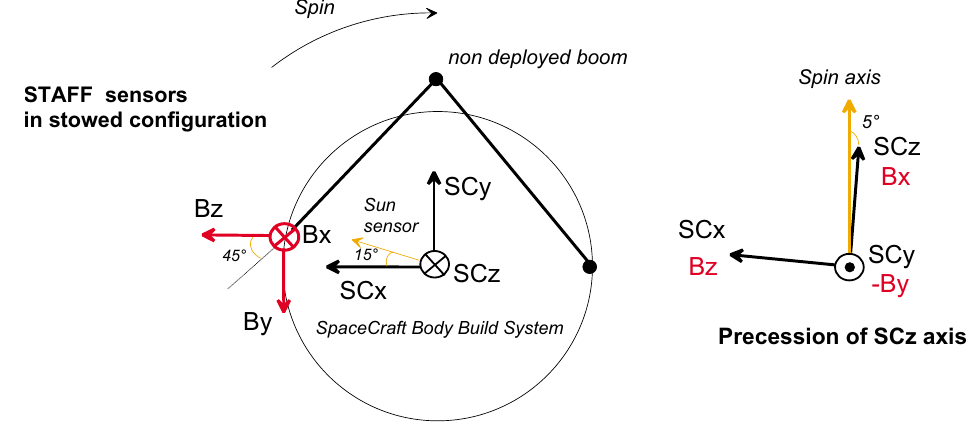
Fig. 2. Relationship between STAFF search coil electrical axis ( B ), in the present stowed configuration, and the spacecraft built axis ( SC ).